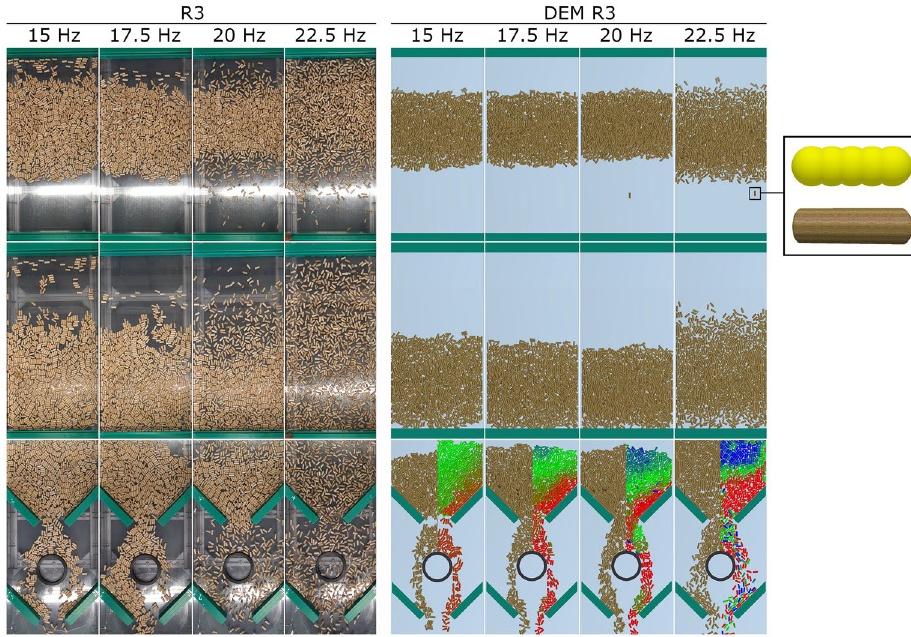
Figure 20. Comparison of real measurements and simulation calculations for R3 wooden